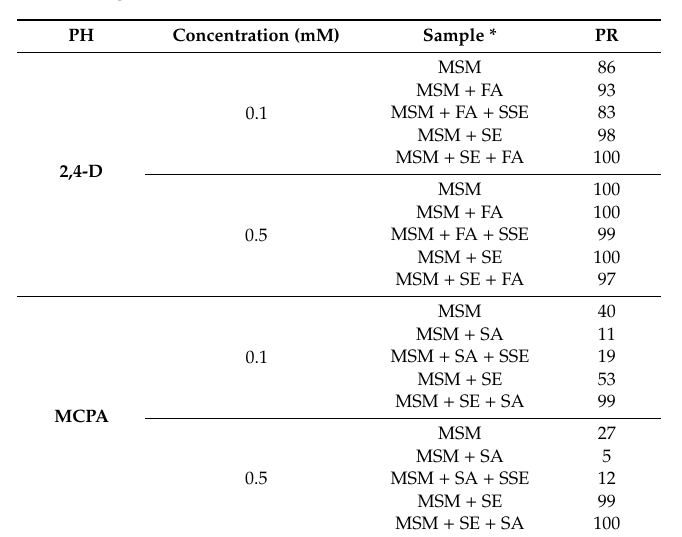
Table 2. Percentage Removal (PR) of PH (2,4-D and MCPA) in Studied Samples. PH Concentration (mM) Sample * PR